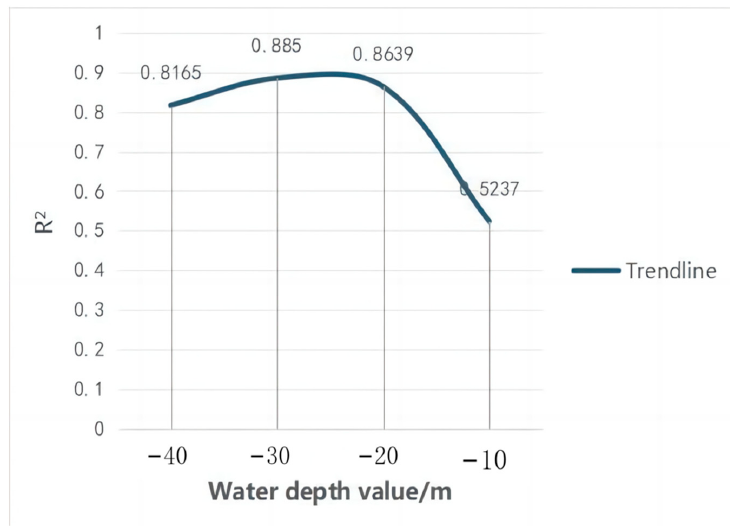
Figure 13. Trends in R 2 across different water depth